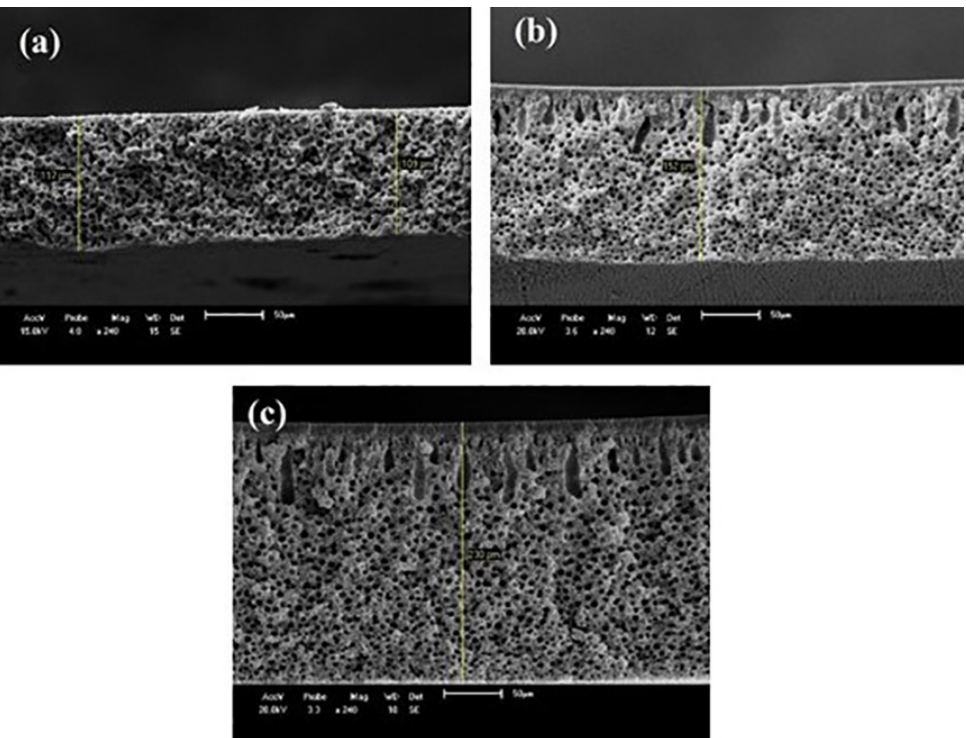
Figure 7. SEM cross-sectional images of the membranes of: (a) PA6; (b) PA6 + 3%MMT; and (c) PA6 + 5%MMT